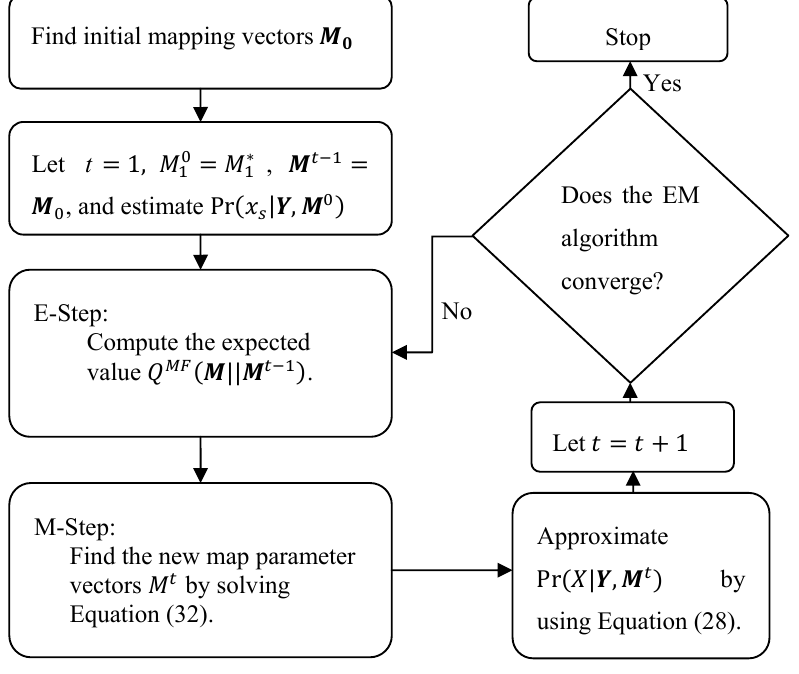
Figure 2. Block diagram of the modified expectation maximization (EM)